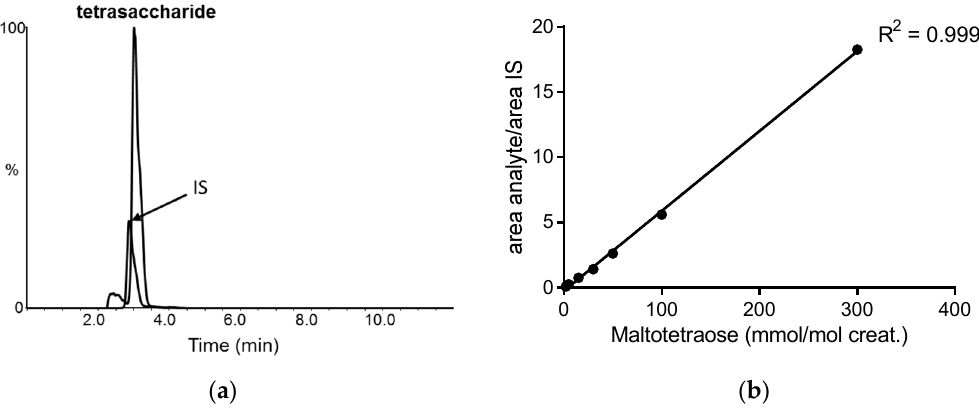
Figure 1. Liquid chromatography tandem mass spectrometry of urine tetrasaccharide: ( a ) extracted ion chromatogram of the tetrasaccharide and internal standard (IS); ( b ) calibration curve of maltotetraose concentration plotted against the ratio of the peak area of the analyte to that of the IS.